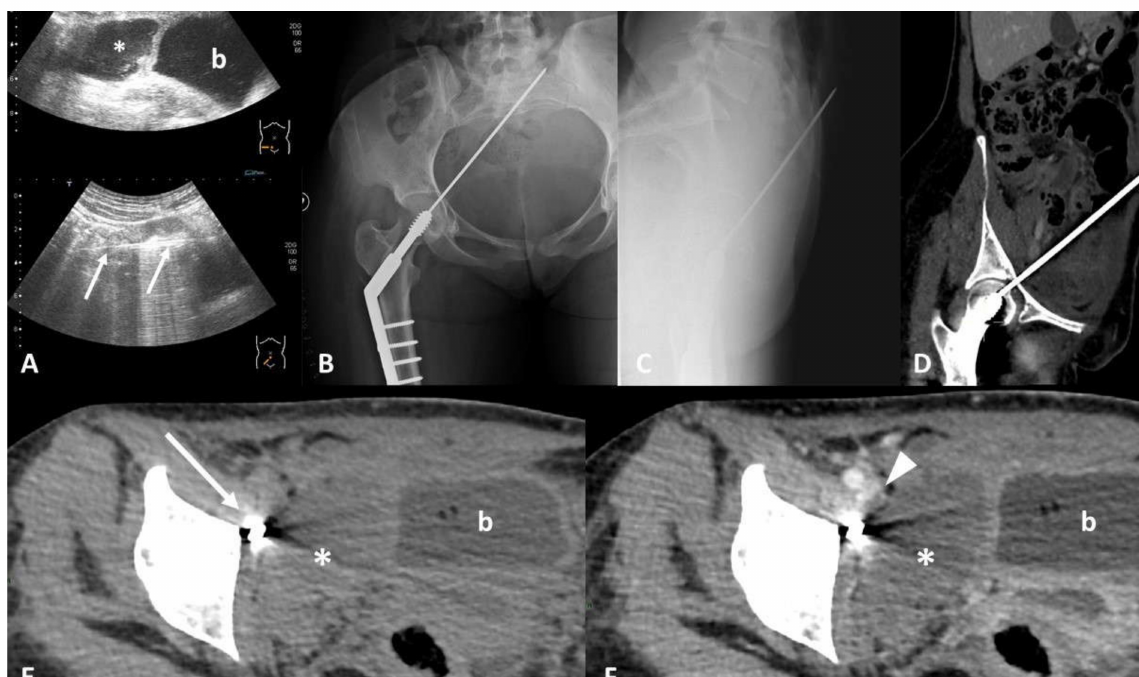
Figure 1. Device identification and recognition. Twenty-nine-year-old female with acute abdominal pain after surgical repair of a traumatic femoral neck fracture. Ultrasound scans ( A ) show a hypoechoic collection (*) in the right iliac fossa, close to the bladder (b), and a linear hyperechoic image with sonographic artifacts (arrows). Frontal ( B ) and lateral ( C ) radiographs show a sharp portion of the osteosynthesis passing through the pelvis, with the tip into the soft tissue of the anterior abdominal wall. Computed Tomography (CT) multiplanar reconstruction images better show the course of the misplaced device from the femoral head to the anterior abdominal wall ( D ). Non-enhanced CT scan ( E ) confirms a large collection (*) in the right iliac fossa, next to the misplaced device (arrow), characterized by hematic density. Contrast-enhanced CT images ( F ) better define the relationship between the collection (*) and the iliac vessels, showing a hypodense filling defect (arrowhead) inside the right external iliac vein (EIV), suggesting the diagnosis of a hematic collection due to iatrogenic injury of the EIV caused by the misplaced